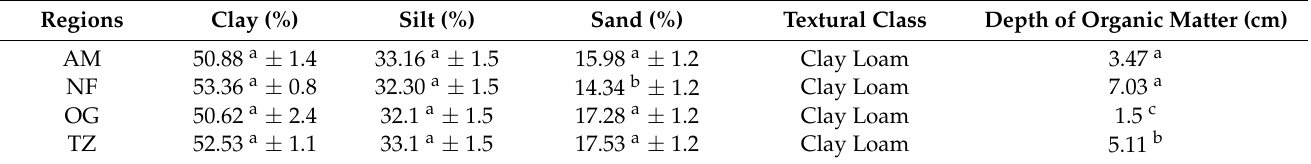
Table 2. Particle-size distribution of the soils in the regions under